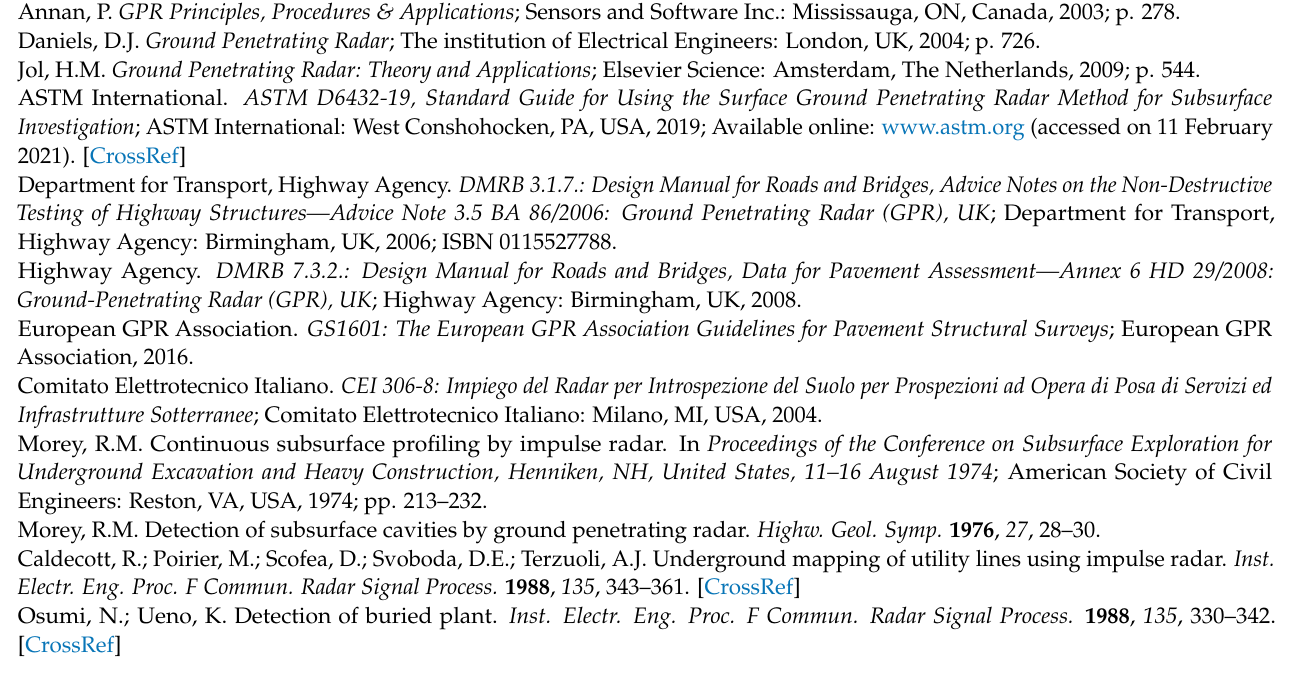
GPR surveys, Table S3: Railways: relevant on-site GPR surveys, Table S4: Retaining walls: relevant on-site GPR surveys, Table S5: Bridges: relevant on-site GPR surveys, Table S6: Tunneling: relevant on-site GPR